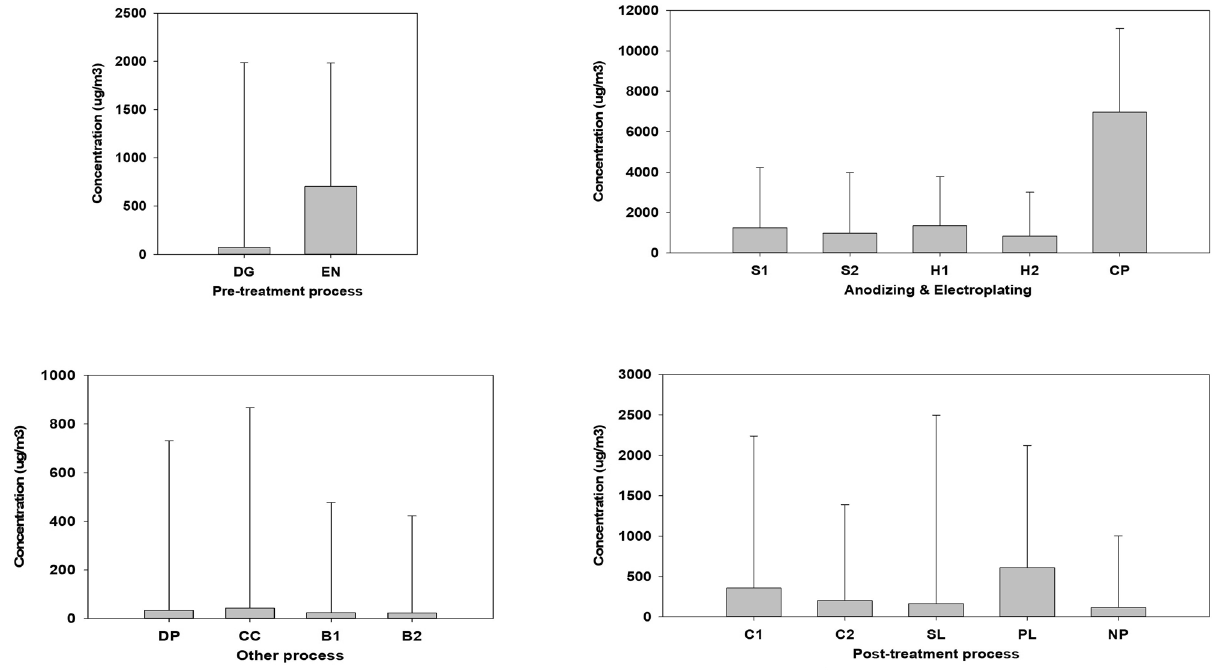
Figure 5. Ratio of heavy metals and other substances in all the processes. The heavy metals concentrations are arithmetic means for a total of seven heavy metals. Error bar denote other substances. DG Degreasing, EN Etching & Neutralization, S1 Soft Anodizing_1, S2 Soft Anodizing_2, H1 Hard Anodizing_1, H2 Hard Anodizing_2, CP Chromium plating, C1 Coloring_1, C2 Coloring_2, SL Sealing, PL Polishing, NP Non polishing, DP Drying & Packaging, CC Chromium cleaning, B1 Blank (Plating & Anodizing), B2 Blank (Drying &